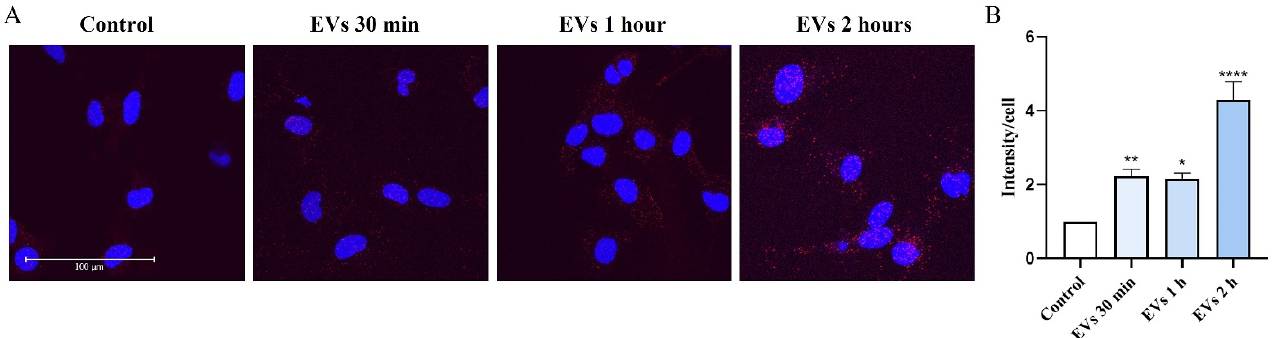
Figure 5. EVs promote association between MFG-E8 and P2X4R proteins in human microglia. ( A ) Confocal images of proximity ligation assay (PLA) dots (red) in human microglial cells. The cells were treated with 1AU of EVs for 30 min, 1 h and 2 h before PLA was conducted. Nuclei, DAPI (blue). Scale bar = 100 μ m. ( B ) PLA dots per cell were counted using the ImageJ program. Data shown represent results of 10 fields of view for each experimental group from three independent biological experiments. Data represents mean ± SEM, * p < 0.05; ** p < 0.01; **** p < 0.0001; n = 3; Kruskal–Wallis, Dunn‘s multiple comparisons test.